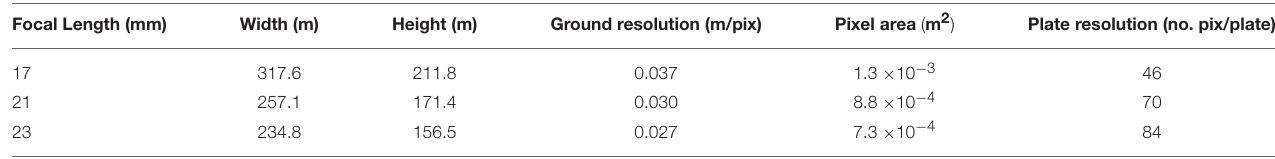
TABLE 2 | Image dimensions, ground resolution, pixel area, and the number of pixels per 28 cm diameter bamboo plate are presented for the focal lengths used during the LASER experiment. Focal Length